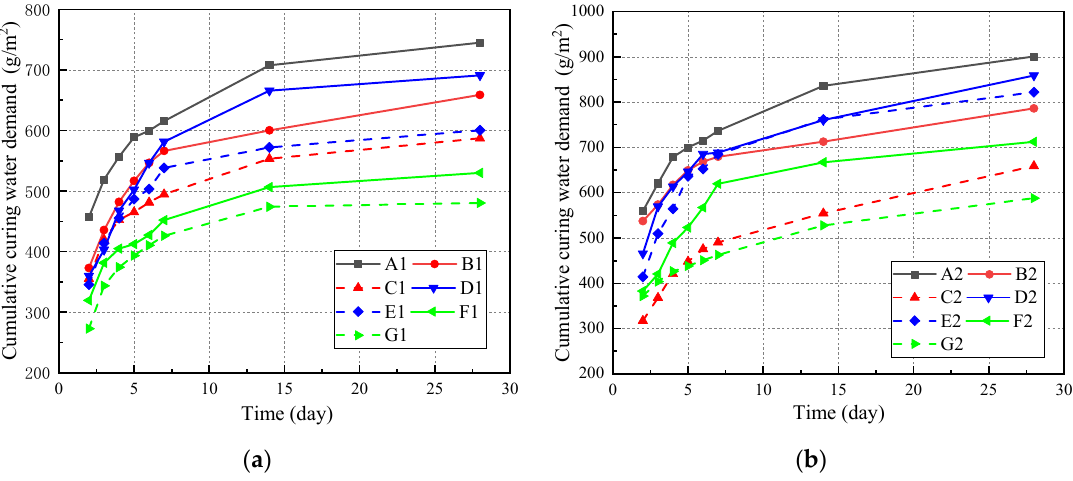
Figure 3. Cumulative curing water demand of different mineral admixtures. ( a ) 0.35; ( b ) 0.45.